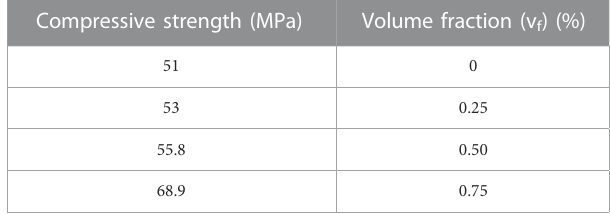
TABLE 6 Compressive strength.